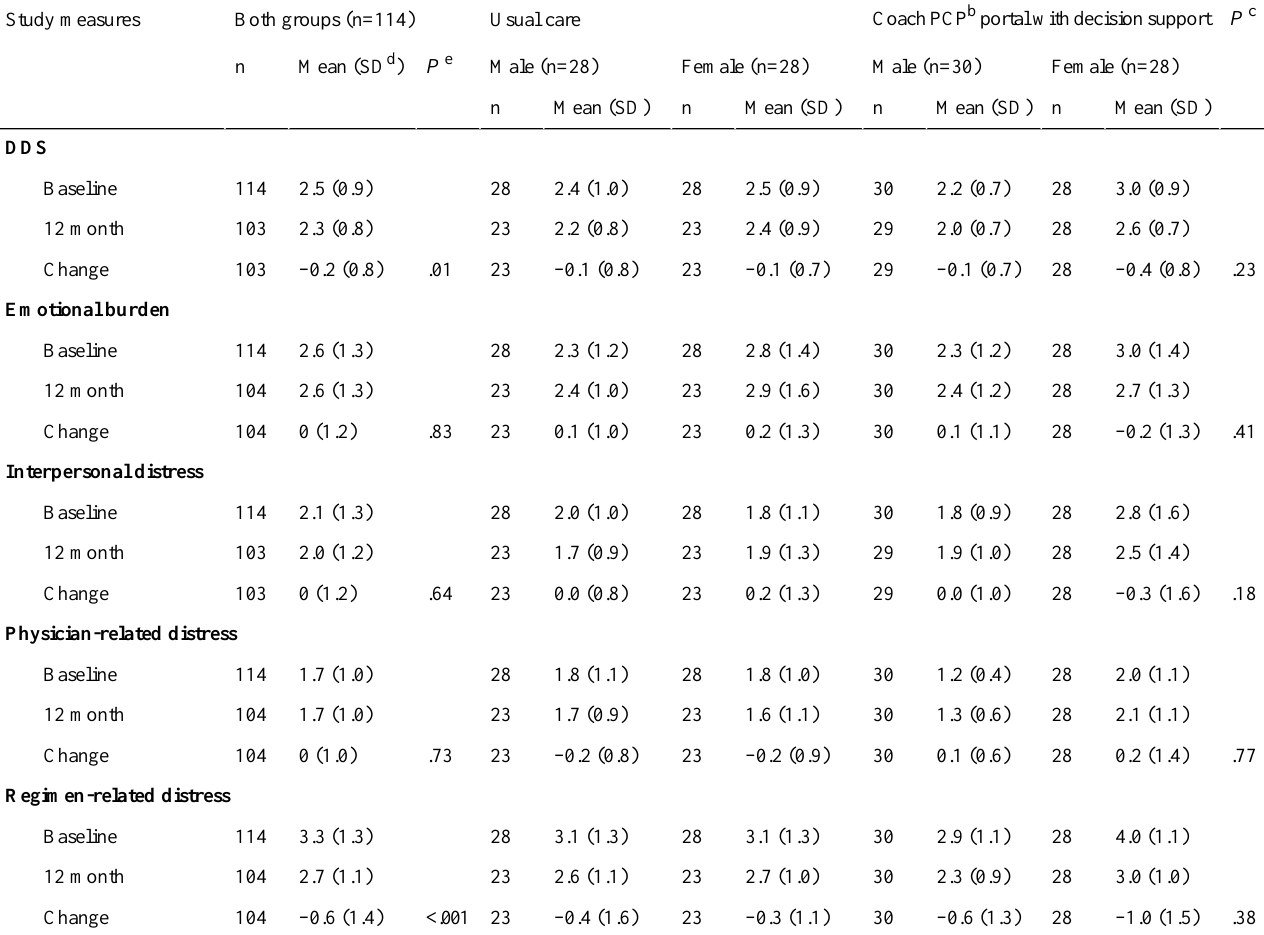
Table 3. Diabetes Distress Scale (DDS) a and subscale scores by